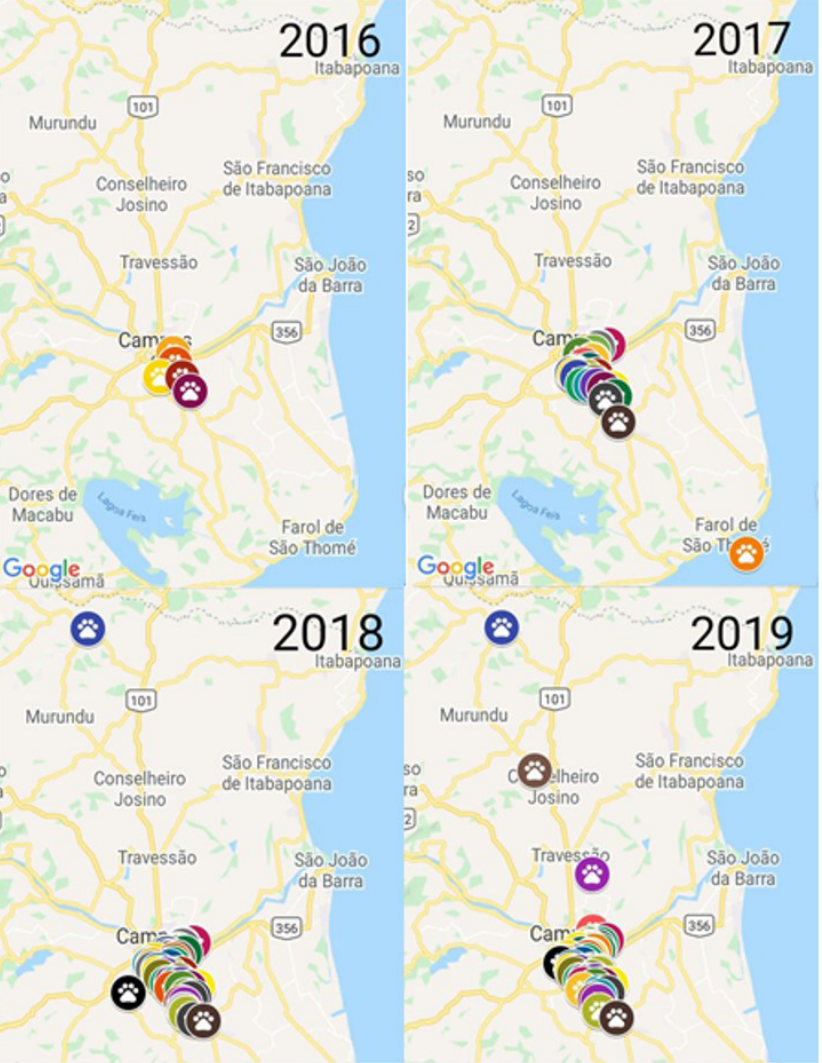
Figure 3. Geographical distribution of sporotrichosis . Note. Geographical distribution of positive animal cases in the neighborhoods of Rio de Janeiro, in the period of 2016 to 2019. The icons in the map represent the neighborhoods affected, not the number of animal